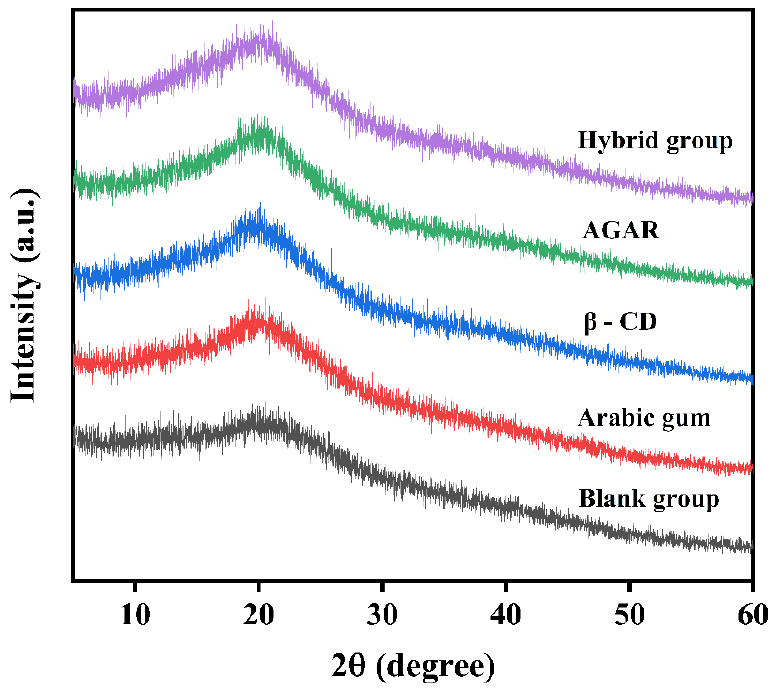
Figure 5. X ‐ ray diffraction spectra of milk tea with different stabilizers. Figure 5. X-ray diffraction spectra of milk tea with different